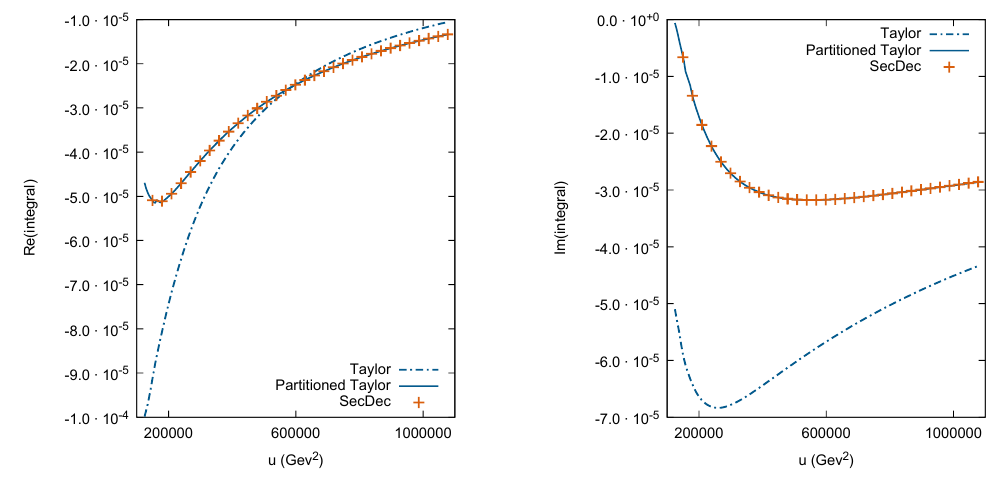
Figure 9 . I10 integral at O ( (cid:15) 0 ) over the 4 m 2 scales are m 2 = m 1 p and m 1 = 173 2